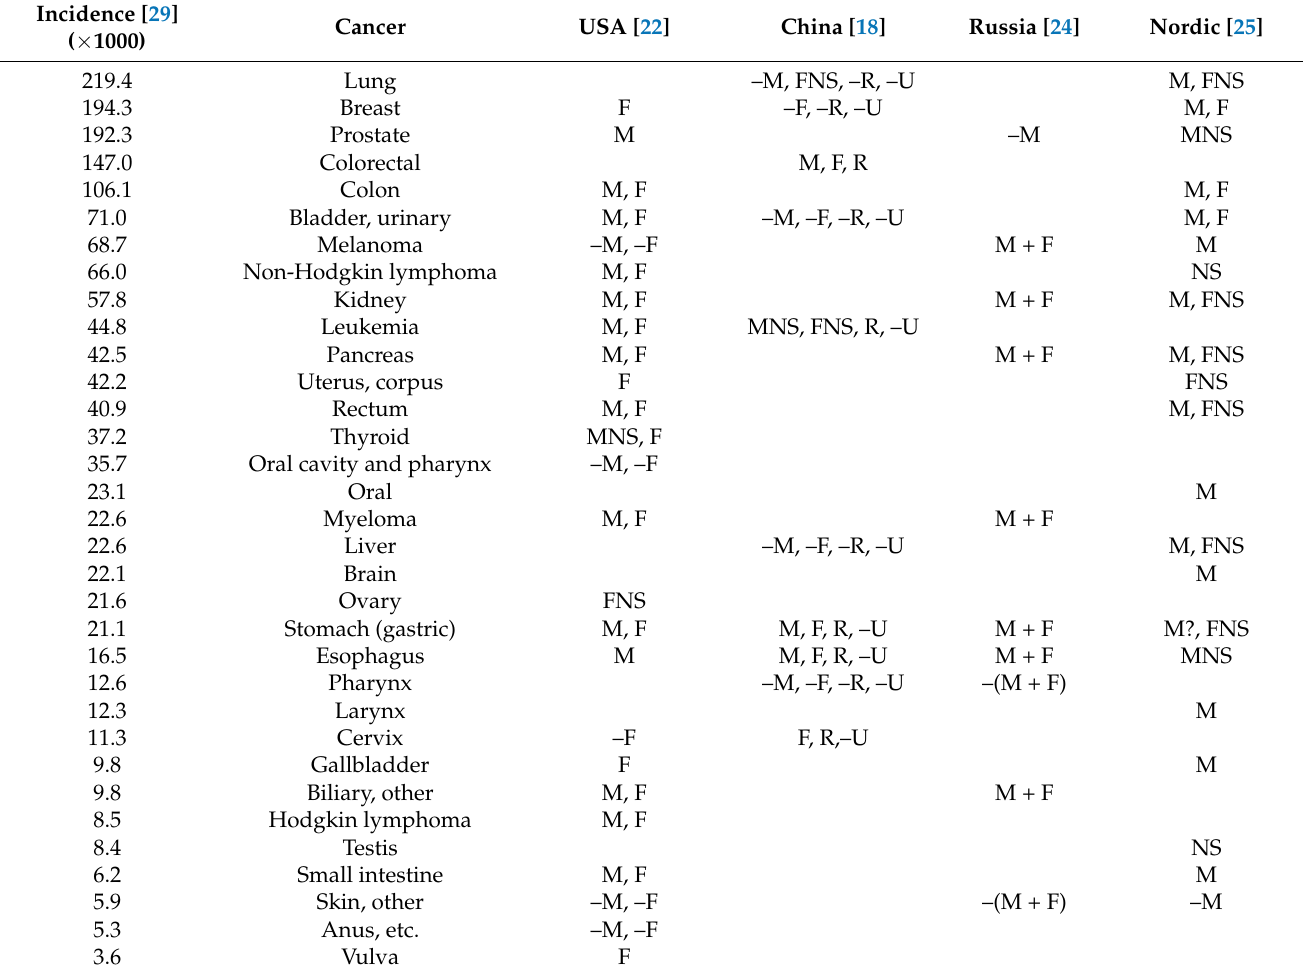
Table 2. Ecological studies of cancer incidence rates with respect to indices of solar UVB doses. Incidence [29]